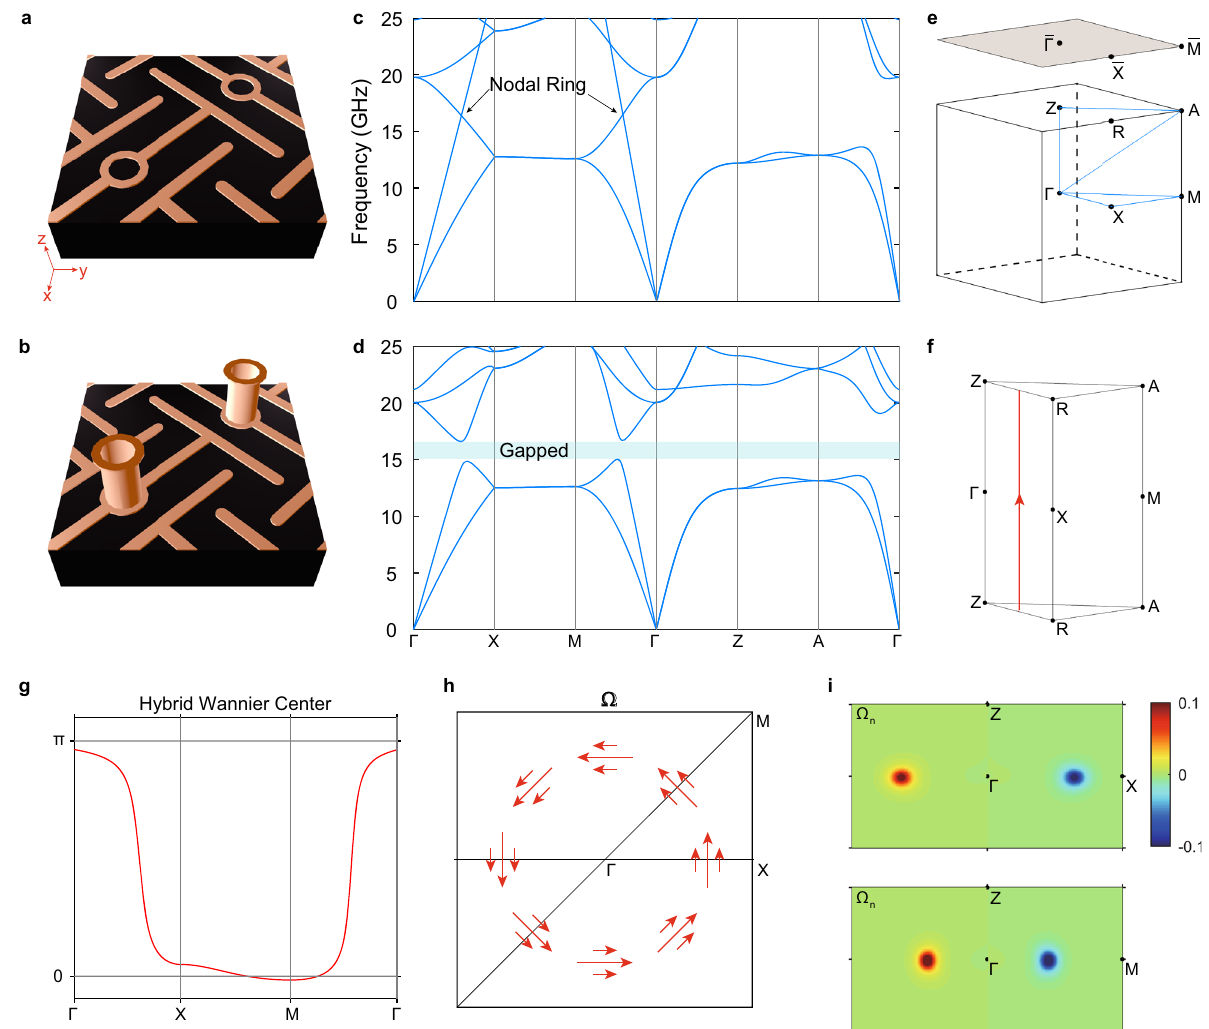
Fig. 2 Realizing momentum-space toroidal moment (MTM) in a photonic meta-crystal. a Nodal ring in photonic meta-crystal protected by mirror symmetry M z . b Breaking M z results in a gapped nodal ring. c , d Band structure along high symmetry lines as de fi ned in e for gapless nodal ring and fully gapped nodal ring, respectively. The complete band gap is shadowed. e First Brillouin zone (FBZ) with high symmetry points labeled. The momentum path of band structure is indicated explicitly. f Reduced FBZ for Wannier center and Berry curvature calculation. g Hybrid Wannier center calculated along Γ XM Γ . The Berry phase accumulating direction is indicated by the red line and arrow in f . h Berry curvature on the k distribution. i Calculated Berry curvature distribution on the k y ¼ 0 plane (upper panel) and k x ¼ k y plane (lower panel). NATURE COMMUNICATIONS| (2021) 12:1784